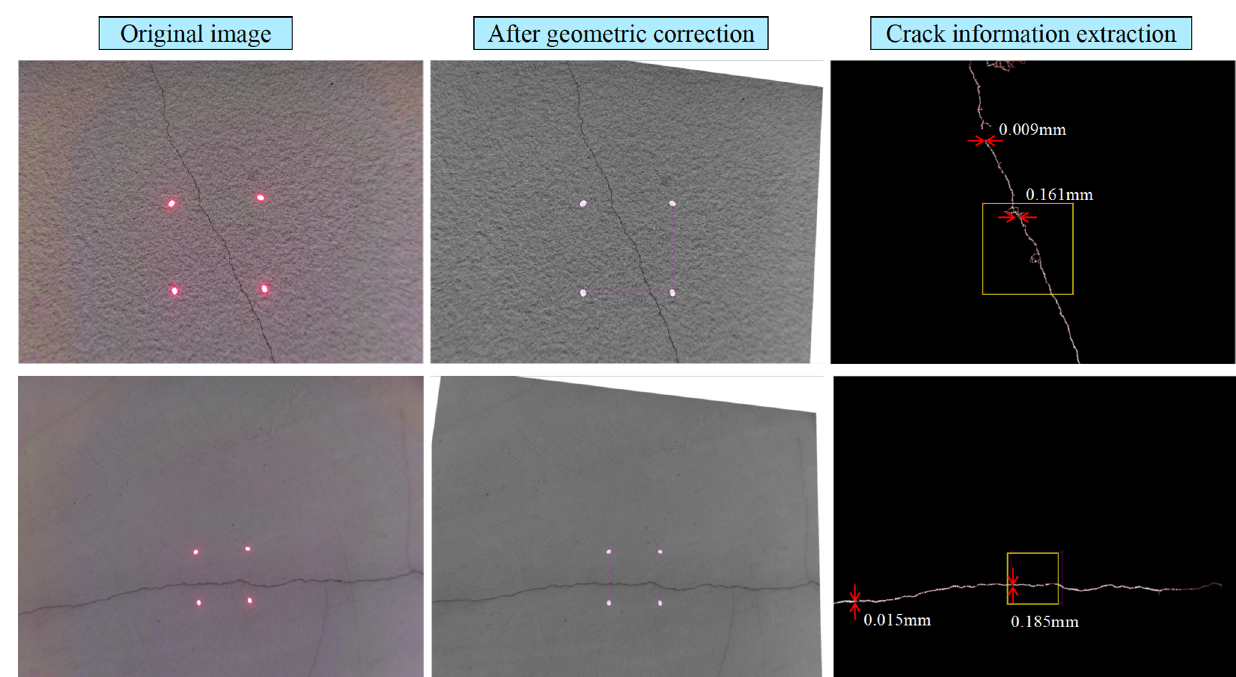
Figure 11. Crack detection software process.